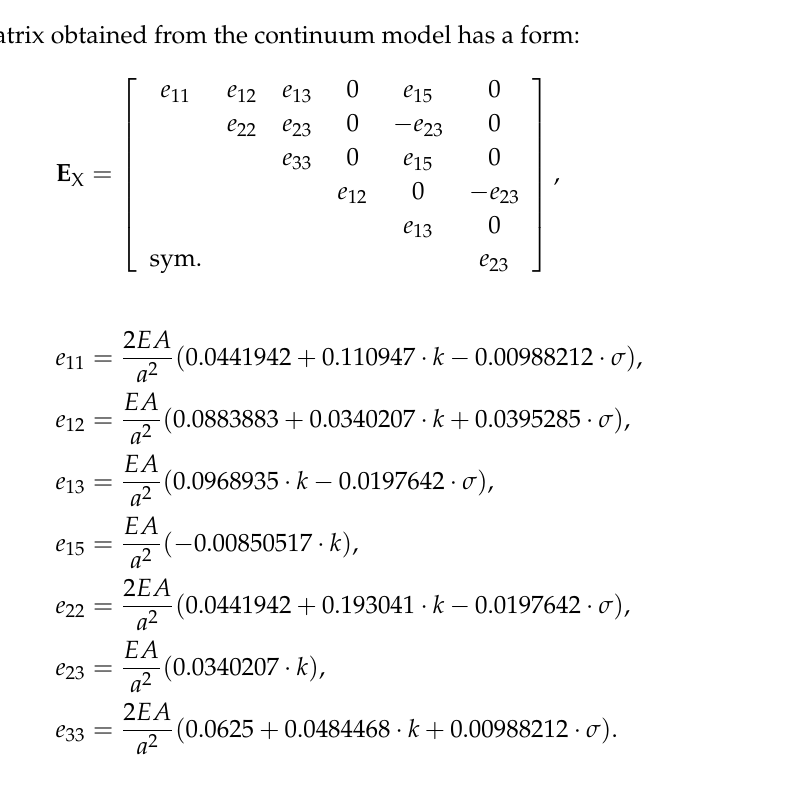
Figure 16. Geometry of the